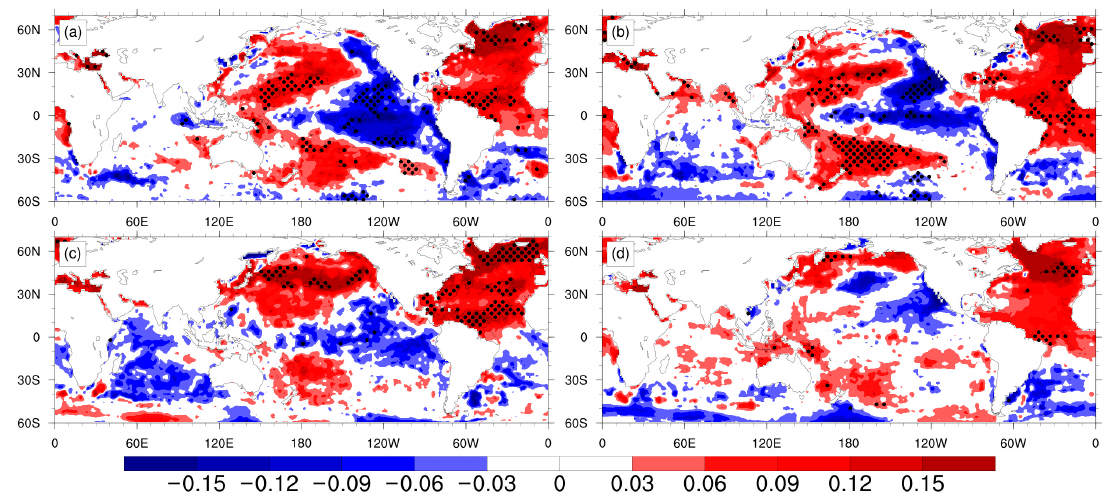
Figure 4. Regressions of the sea surface temperature (SST) anomalies onto the first principle component of the decadal-to-multidecadal variability of land precipitation from GPCC in the northern hemisphere in ( a ) winter, ( b ) spring, ( c ) summer, and ( d ) autumn. Regions exceeding the 95% significance t -test are dotted. Unit: degrees Celsius.